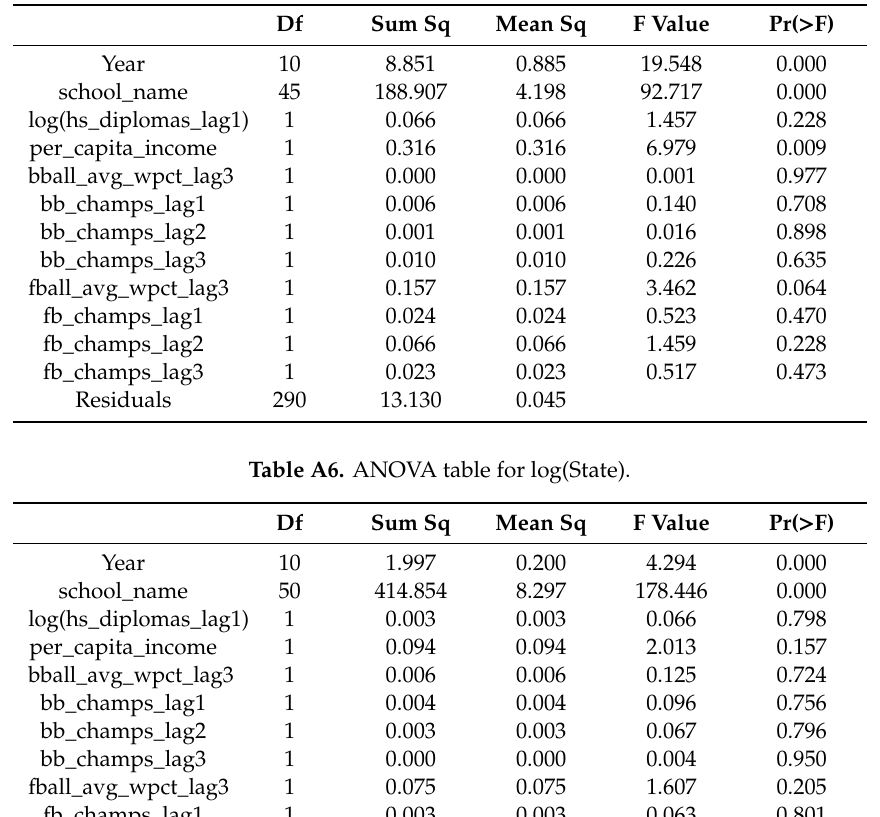
Table A5. ANOVA table for log(NonAthletics).